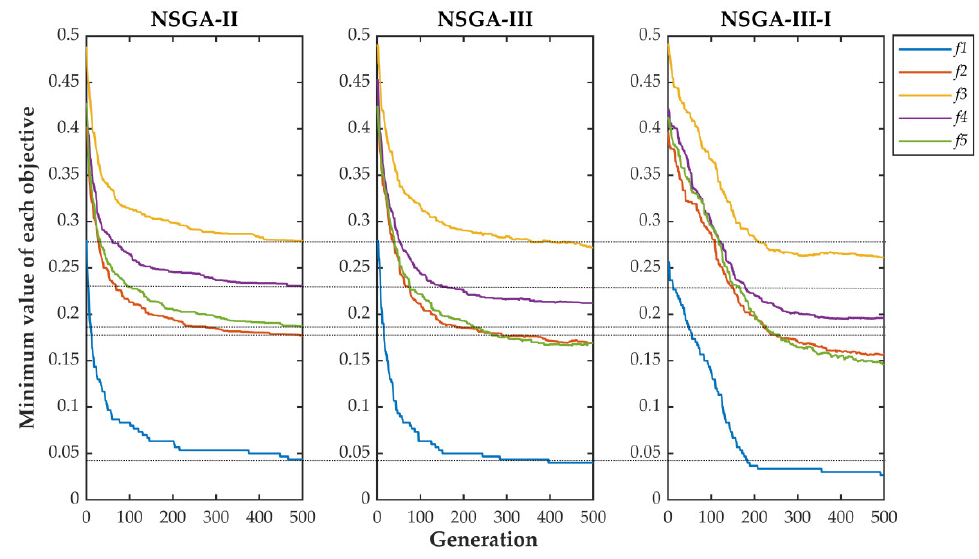
Figure 14. Convergence process of each algorithm.